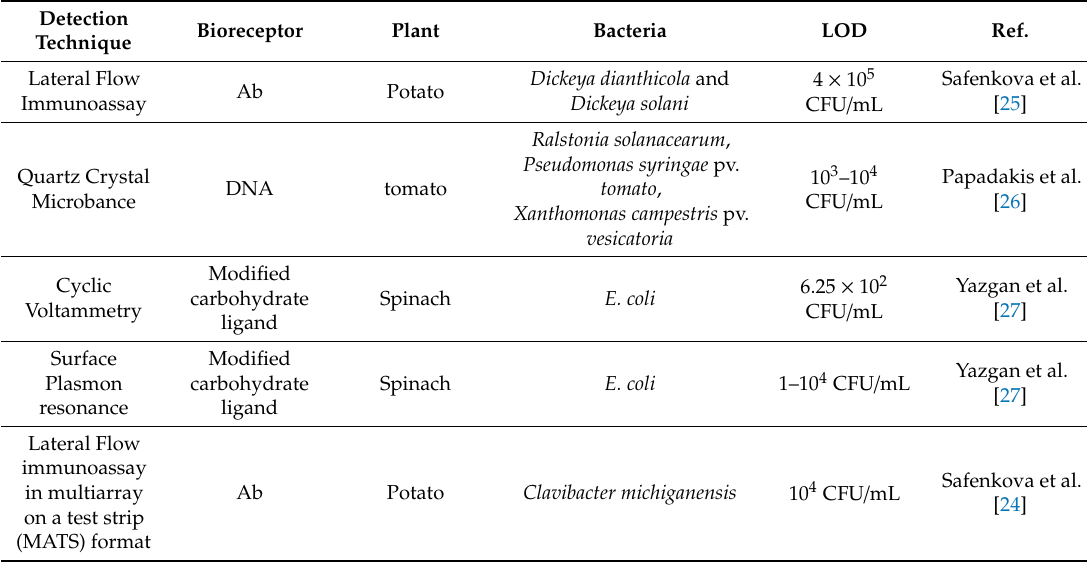
Table 3. Performance comparison with other devices for plant disease